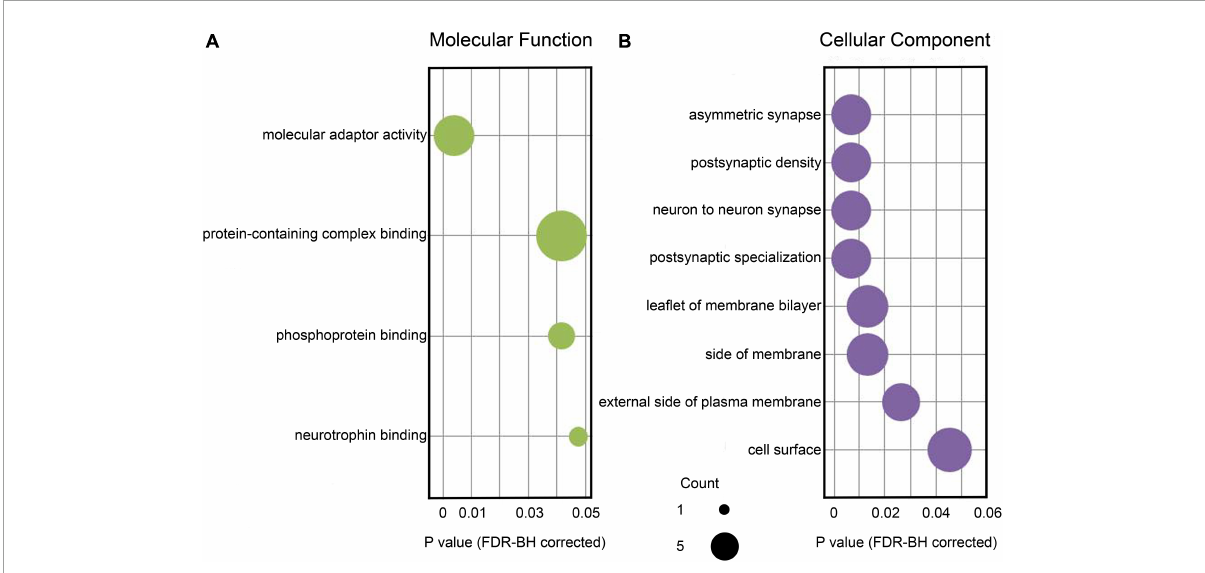
FIGURE4 Enrichment analysis based on the identified 62 genes associated with brain WMV alterations. (A) Significant GO items of molecular function. (B) Significant GO items of cellular component. The x-axis displays corrected P -values for each GO item. The size of each sphere shows the number of genes overlapping with each GO item. GO, gene ontology; WMV, white matter